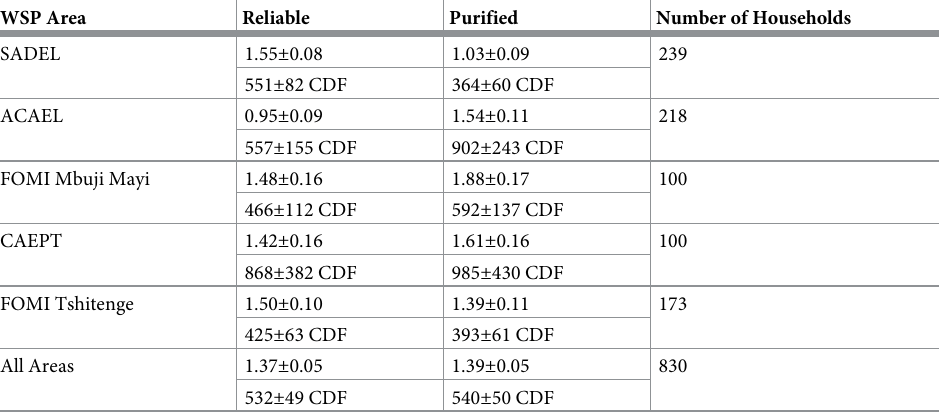
Table 3. Preference and willingness to pay for reliable water and purified water with